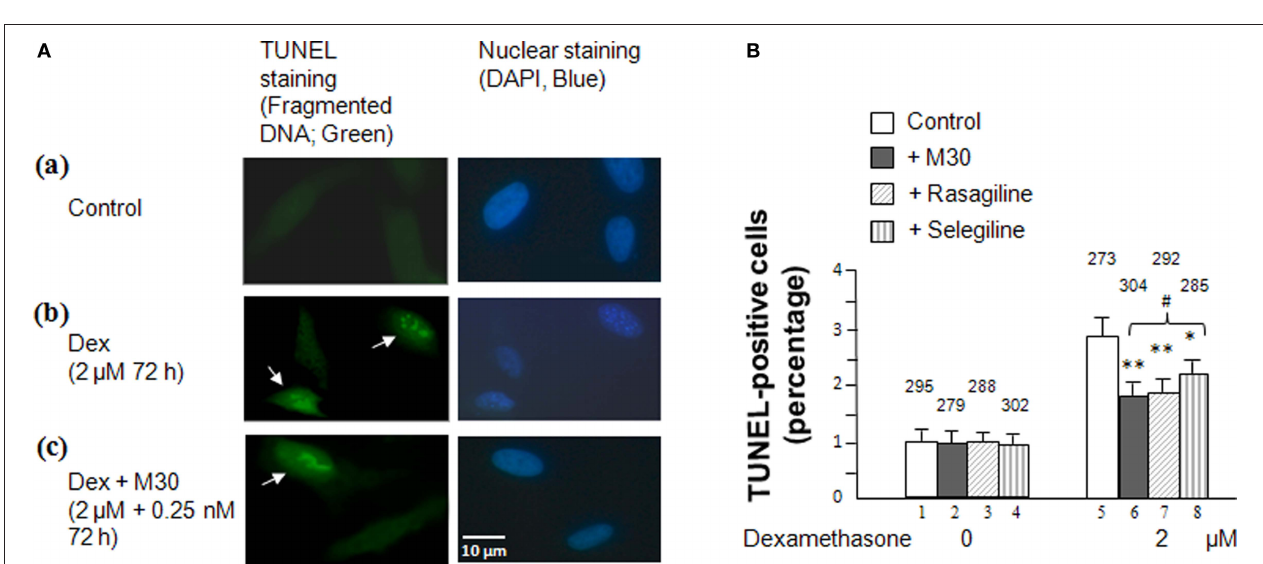
Figure 3 | effects of dexamethasone and MAO inhibitors on cell apoptosis in SHSY5Y cells. (A) . Immunofluorescence showing TUNEL( + ) and TUNEL( − ) cells in (a) control cells, (b) cells treated with 2 μM dexamethasone for 72 h, and (c) cells treated with 2 μM dexamethasone and 0.25 nM M30 for 72 h. Photomicrographs show representative cells from each experimental group and the arrows indicate apoptotic cells. (B) Percentage of cells that contain damaged DNA as revealed by the TUNEL assay in each